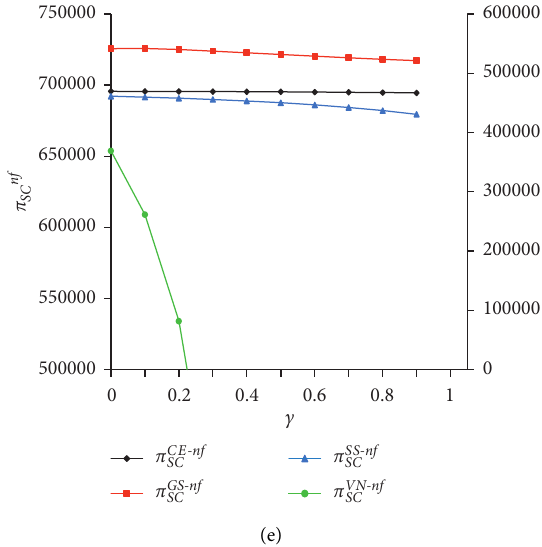
Figure 6: Effects of c on profit